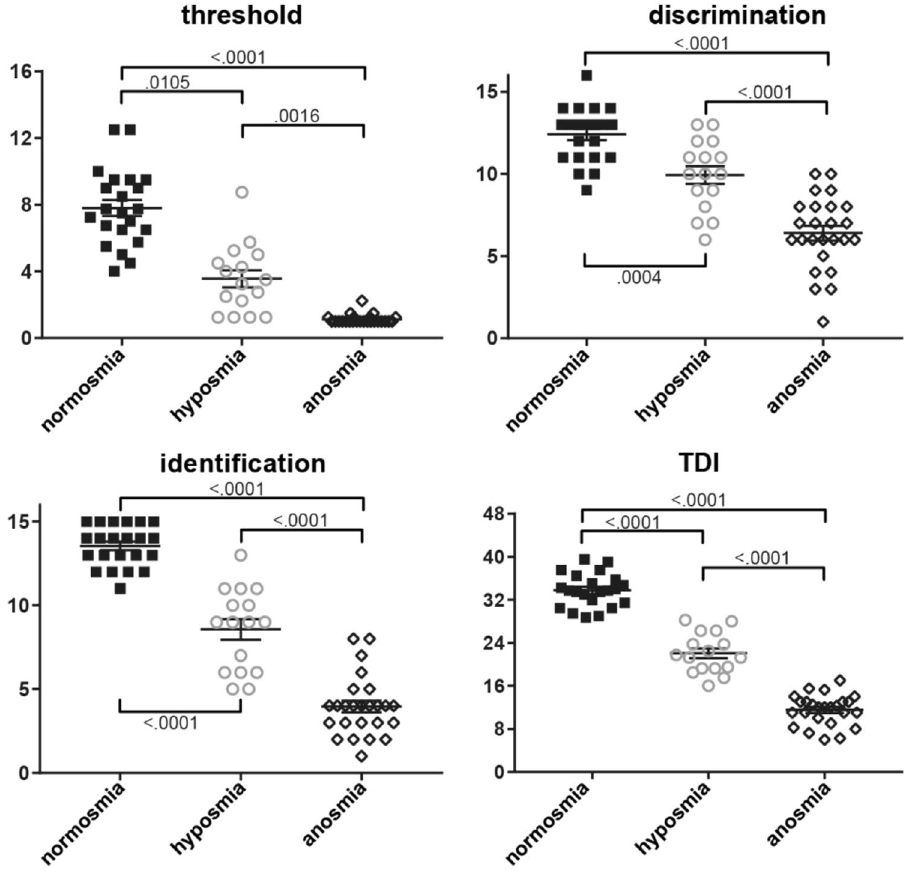
Figure 2. Threshold (upper left panel), discrimination (upper right), identification (lower left), and composite TDI (lower right) score from Sniffin’ Sticks test by group. Legend details as in Fig. 1.